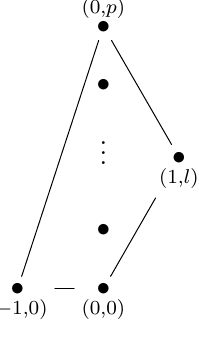
Figure 2 . Toric diagram for Y p,q . We have defined l ≡ p − q